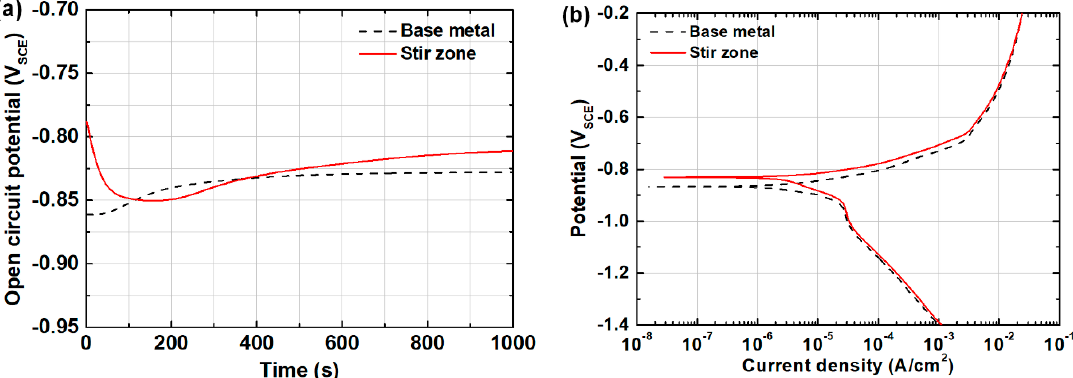
Figure 4. Corrosion tests of base metal and stir zone specimens: ( a ) open circuit potential and ( b ) potentiodynamic plots.